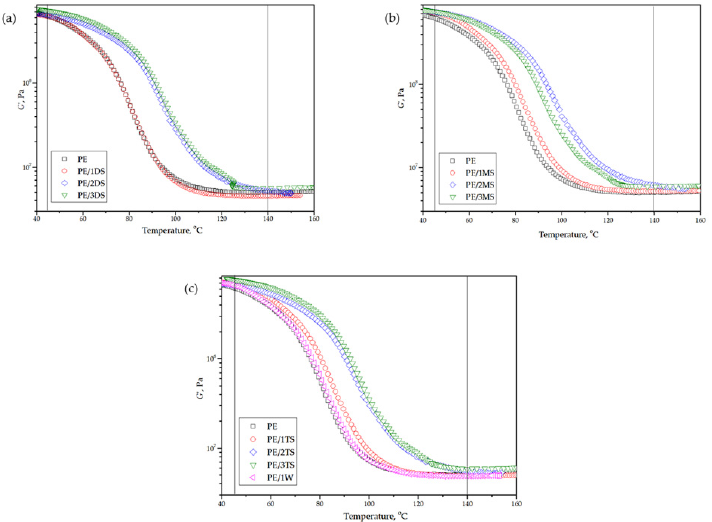
Figure 13. Temperature dependence of storage modulus (G’) of plain epoxy and corresponding composites for ( a ) PE, PE/1DS, PE/2DS, and PE/3DS ( b ) PE, PE/1MS, PE/2MS, PE/3MS ( c ) PE, PE/1TS, PE/2TS, PE/3TS, and PE/1W.